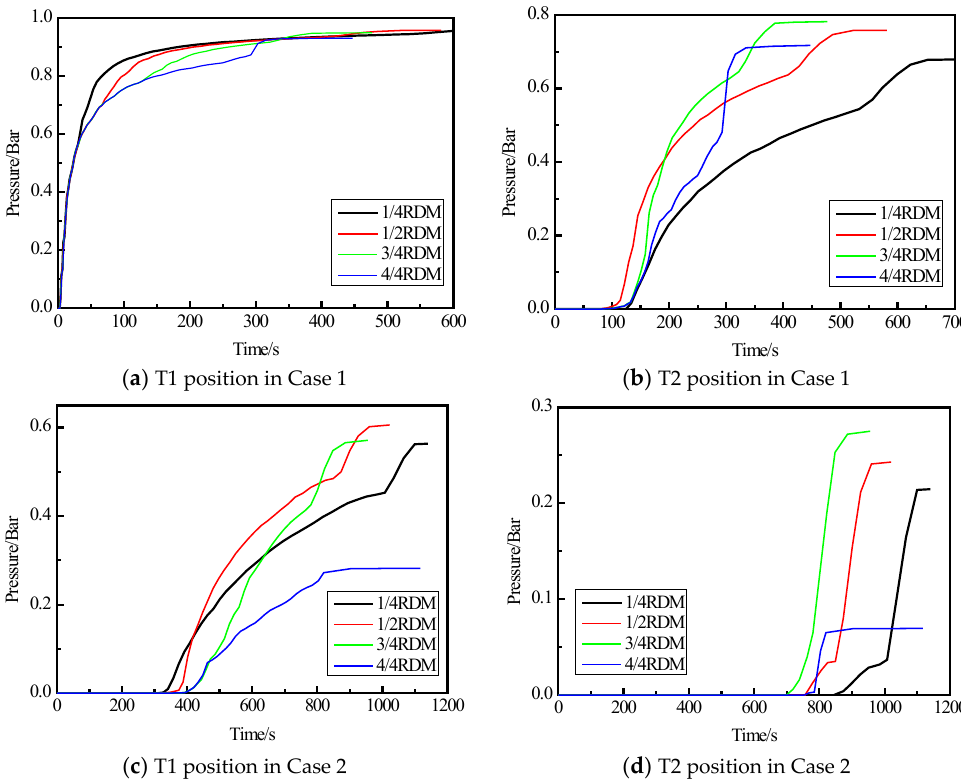
Figure 10. Pressure changes during resin flow under Case 1 and Case 2.